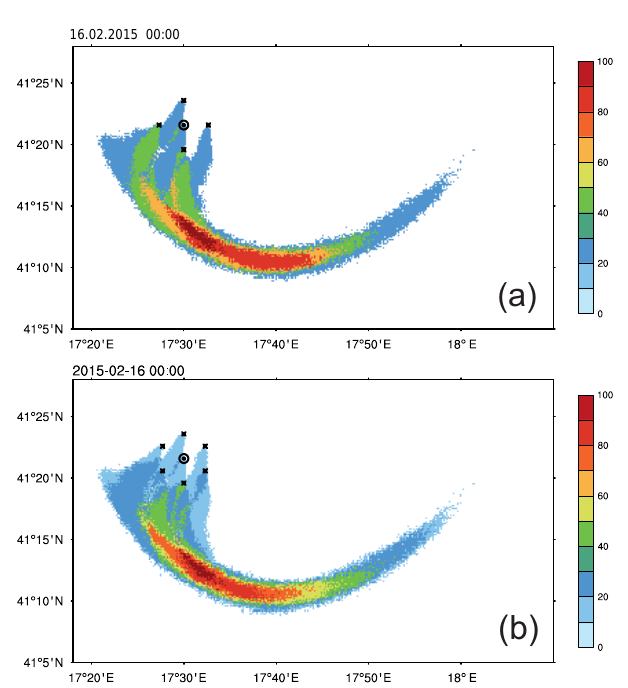
Figure 8. Uncertainty of the oil spill forecast with respect to the starting location of the oil spill (Scenario I): in cross (a) and hexagon (b) configuration.